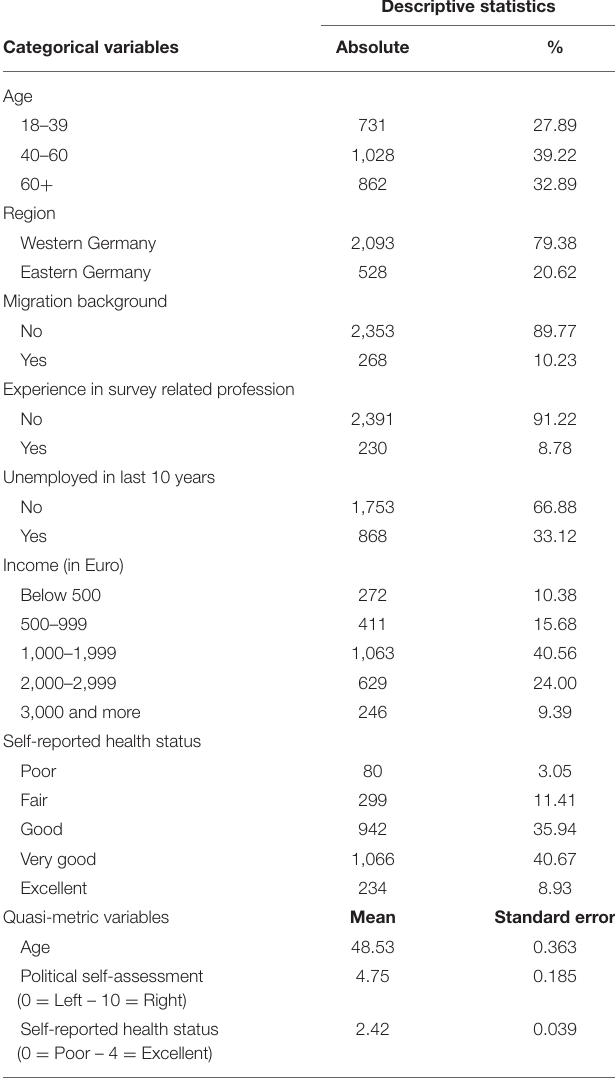
TABLE 2 | Descriptive statistics of respondent characteristics after